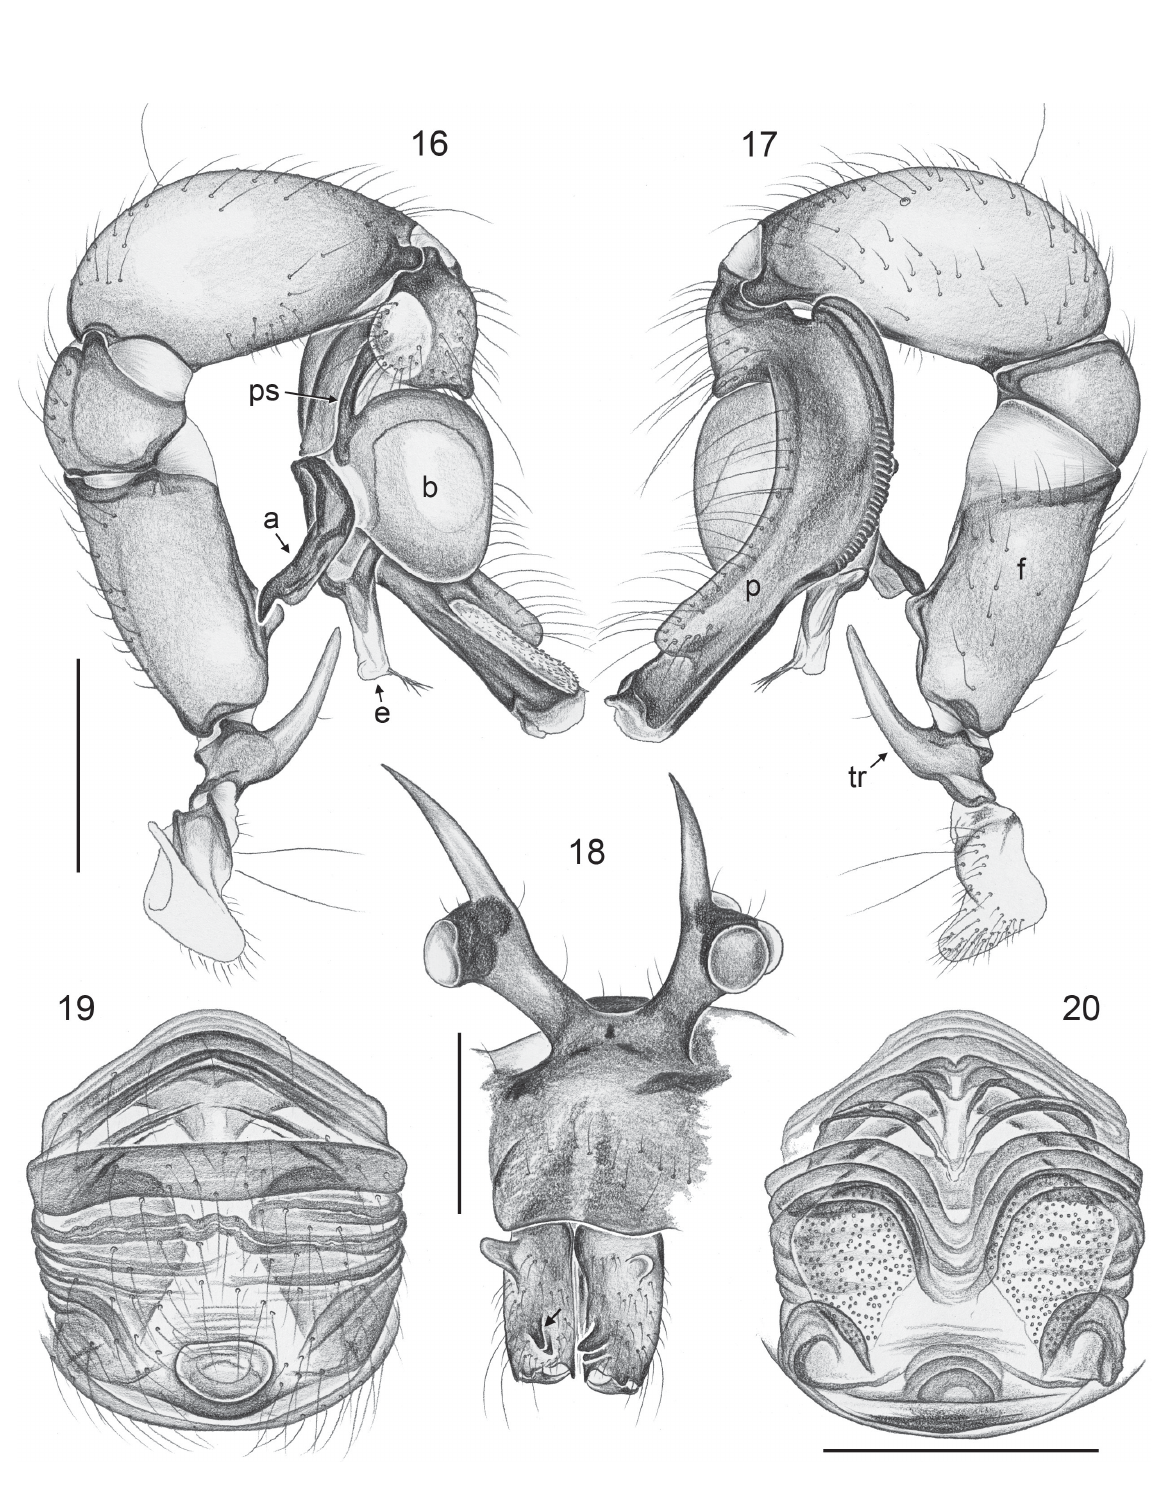
Figs 16–20. Panjange pueh Huber, sp. nov. (ZFMK Ar 14576–77). 16–17 . Left male palp, prolateral and retrolateral views. 18 . Male ocular area, clypeus, and chelicerae, oblique frontal view (arrow points at distal cheliceral apophysis). 19–20 . Cleared female genitalia, ventral and dorsal views. Abbreviations: a = appendix; b = genital bulb; e = embolus; f = femur; p = procursus; ps = proximal bulbal sclerite; tr = trochanter. Scale lines: 0.5